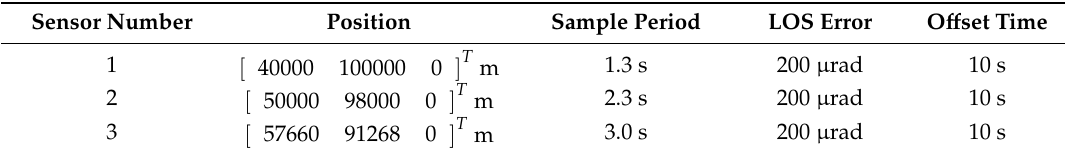
Table 1. Main parameters of sensors in the scenario.